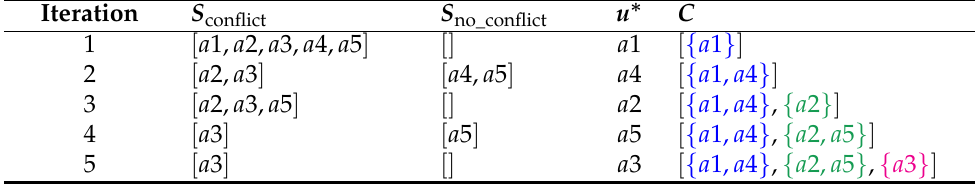
Table 7. Steps of the coloring heuristic applied on the conflict graph shown in Figure